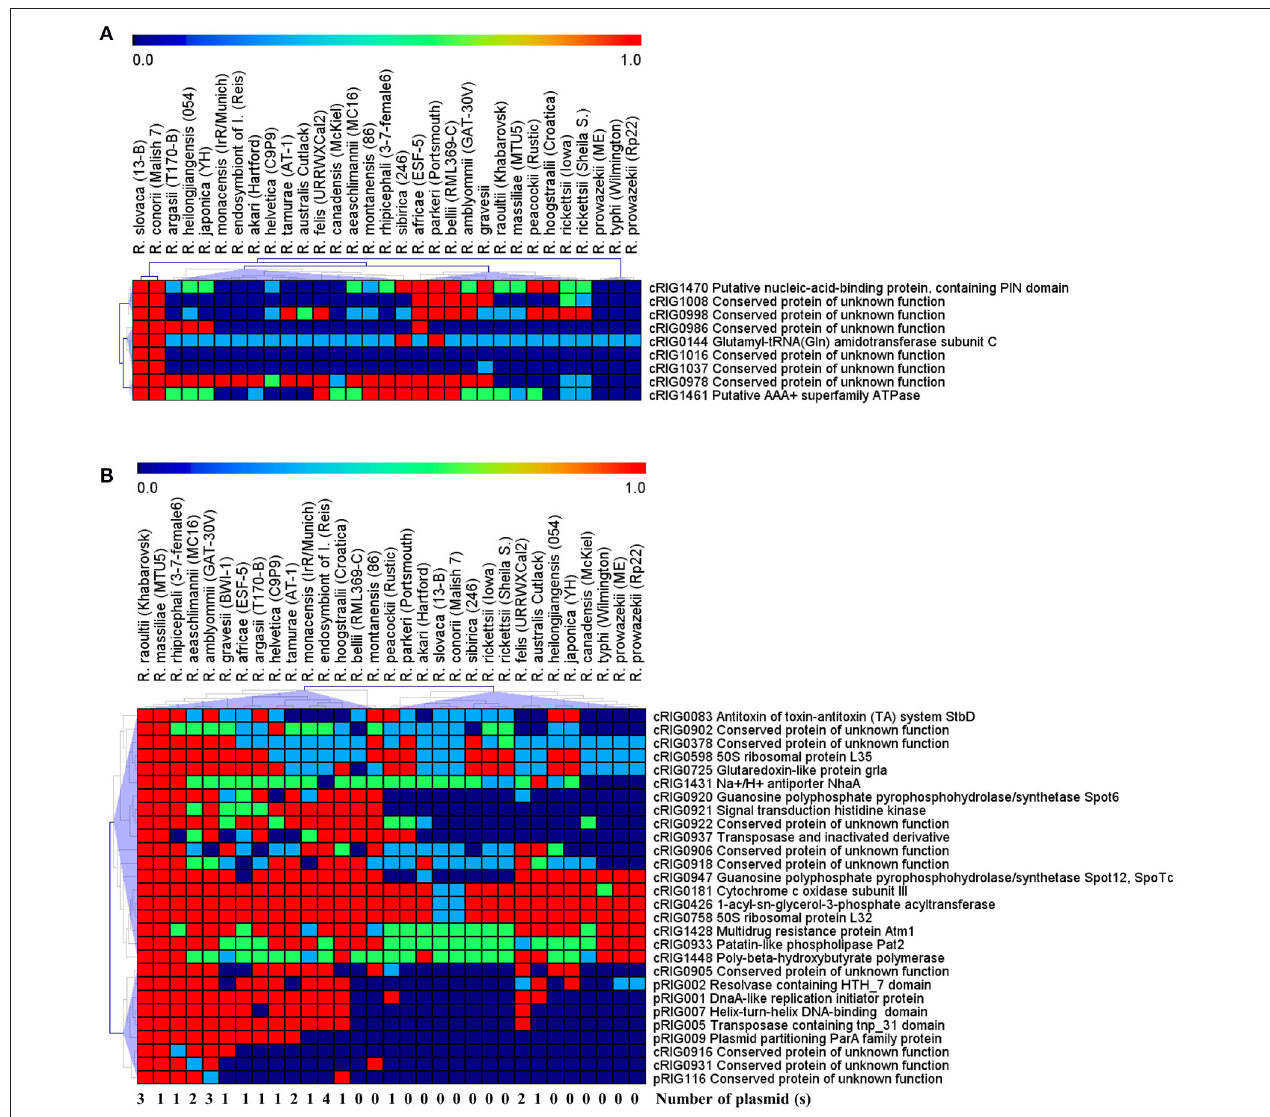
FIGURE 3 | Comparative genomics of 9 complete genes ( ≥ 60 aa in sizes) distinguishing the virulent R. slovaca and R. conorii from the milder R. raoultii and R. massiliae (A) and 28 complete genes ( ≥ 60 aa in sizes) distinguishing the milder R. raoultii and R. massiliae from the virulent R. slovaca and R. conorii (B) , with 25 Rickettsia species. Red, green, light blue, and dark blue colors mean that genes can be either complete, split, fragment and absent/remnant, respectively.